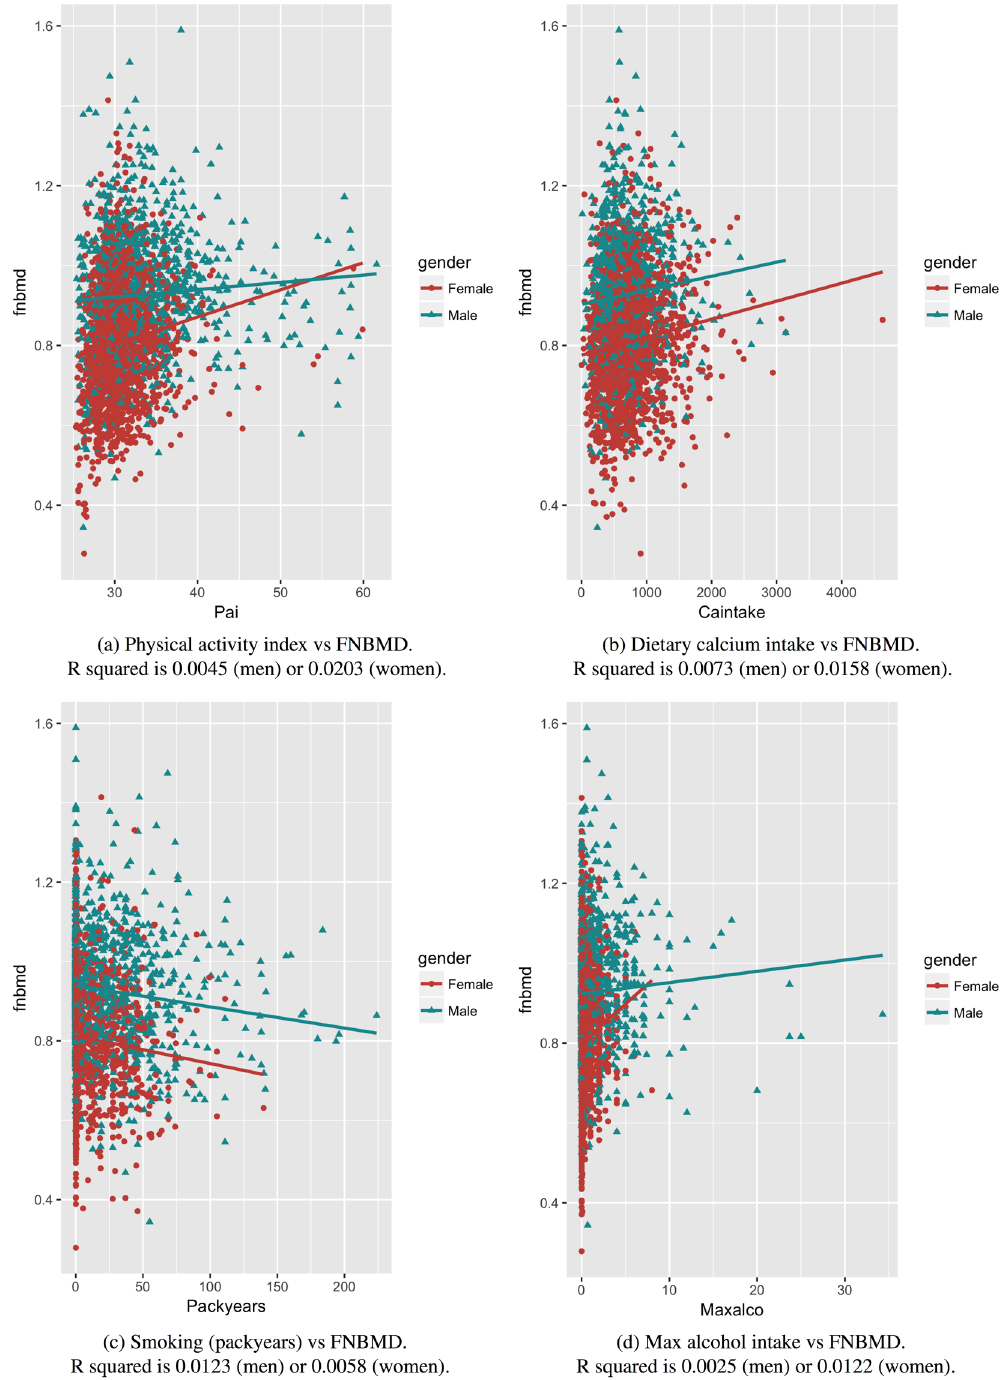
Figure 1. Lifestyle factors against femoral neck bone mineral density (FNBMD). R squared values are reported from corresponding linear regression estimations. The models were note adjusted for age and BMI. ( a ) Physical activity index vs FNBMD. R squared is 0.0045 (men) or 0.0203 (women). ( b ) Dietary calcium intake vs FNBMD. R squared is 0.0073 (men) or 0.0158 (women). ( c ) Smoking (packyears) vs FNBMD. R squared is 0.0123 (men) or 0.0058 (women). ( d ) Max alcohol intake vs FNBMD. R squared is 0.0025 (men) or 0.0122